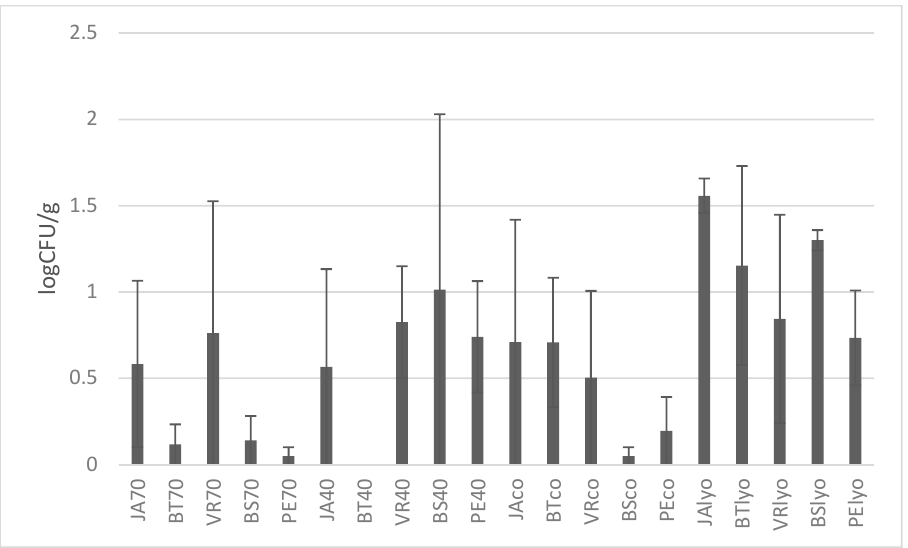
Figure 3. Determination of yeasts in individual varieties depending on drying methods (70 °C, 40 °C, combined, lyophilised) in log CFU/g. Varieties: JA—Jakubské, BT—Beauty seedless, PE—Perlette, VR—Vrboska, BS—Bezsemenné. CFU—colony forming units.